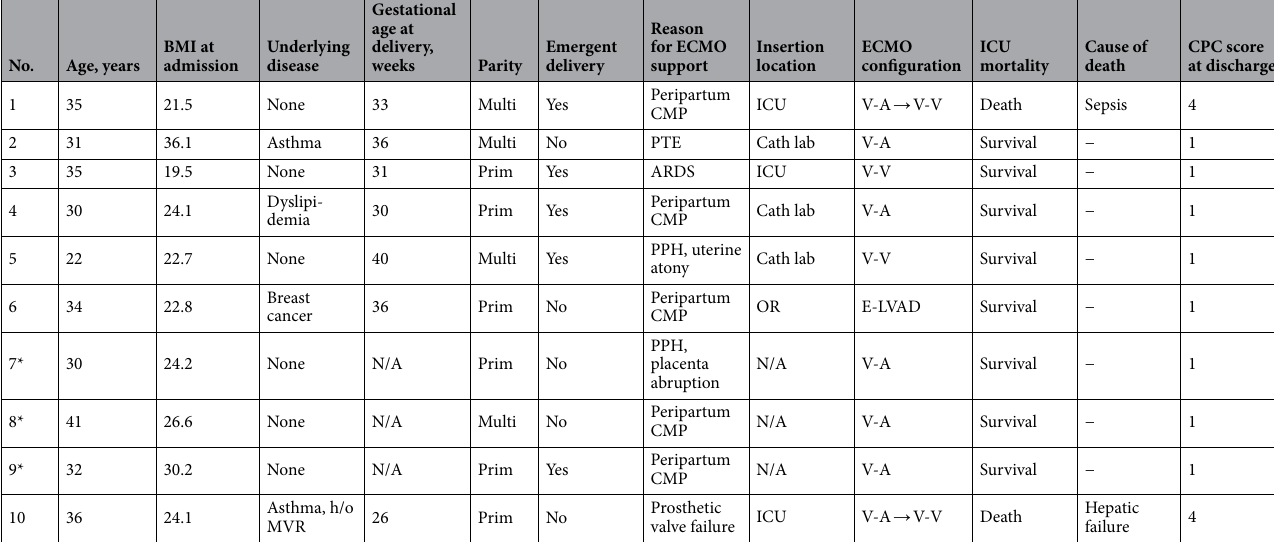
Table 1. Clinical characteristics and outcomes. BMI body mass index, MVR mitral valve replacement, ECMO extracorporeal membrane oxygenator, CMP cardiomyopathy, PTE pulmonary thromboembolism, ARDS acute ECMO